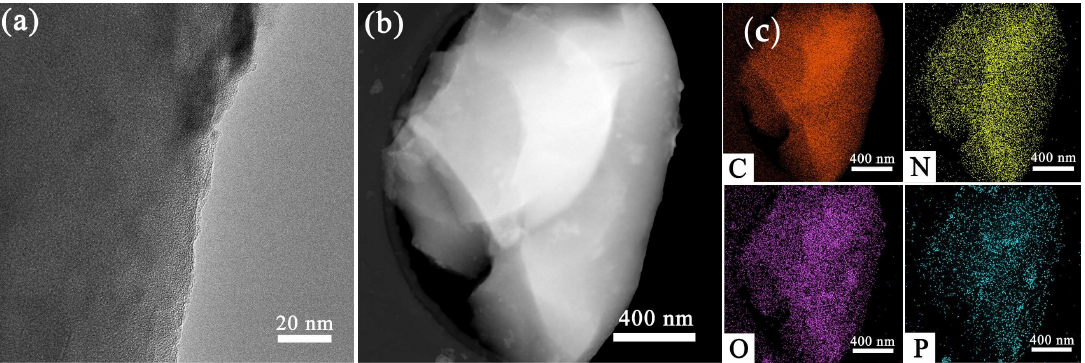
Figure 3. ( a ) High-magnification TEM image, ( b ) low-magnification TEM image and ( c ) element mapping images of C, N, O, and P.